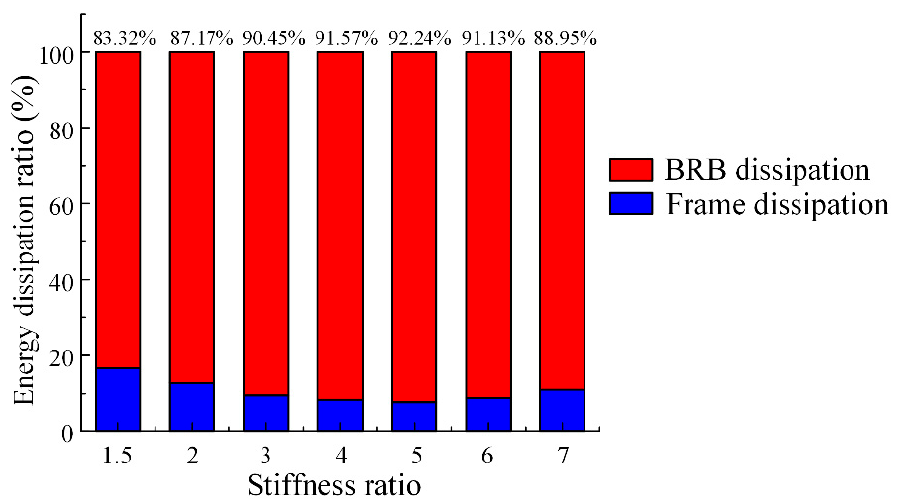
Figure 20. Change of the energy dissipation ratio of BRBs in the four-story PCF-BRB structure.